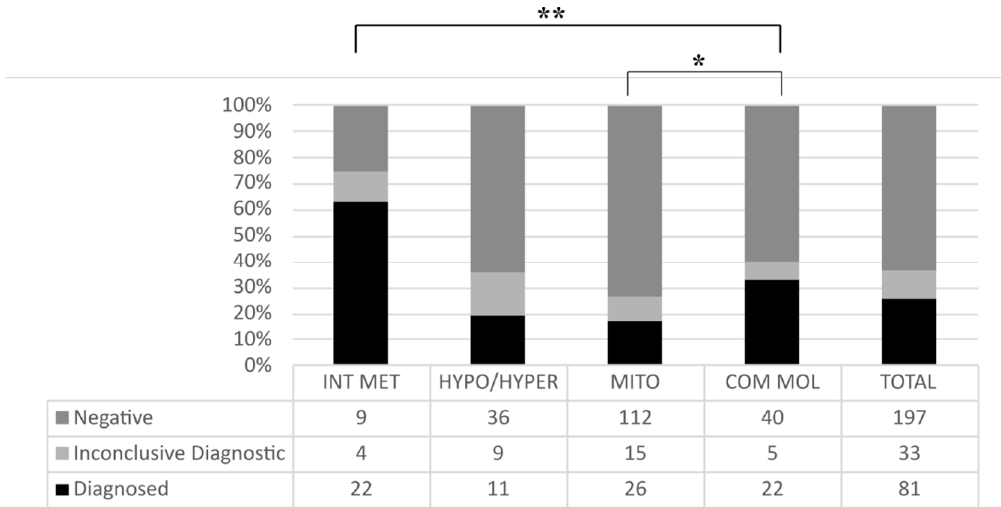
Figure 2. Representation of the overall rate of diagnosis achieved for each panel. For each panel the total number of patients analyzed and the corresponding diagnostic outcome are shown. * p < 0.05; ** p < 0.01 (correlational analysis with Chi-squared and Fisher’s test).